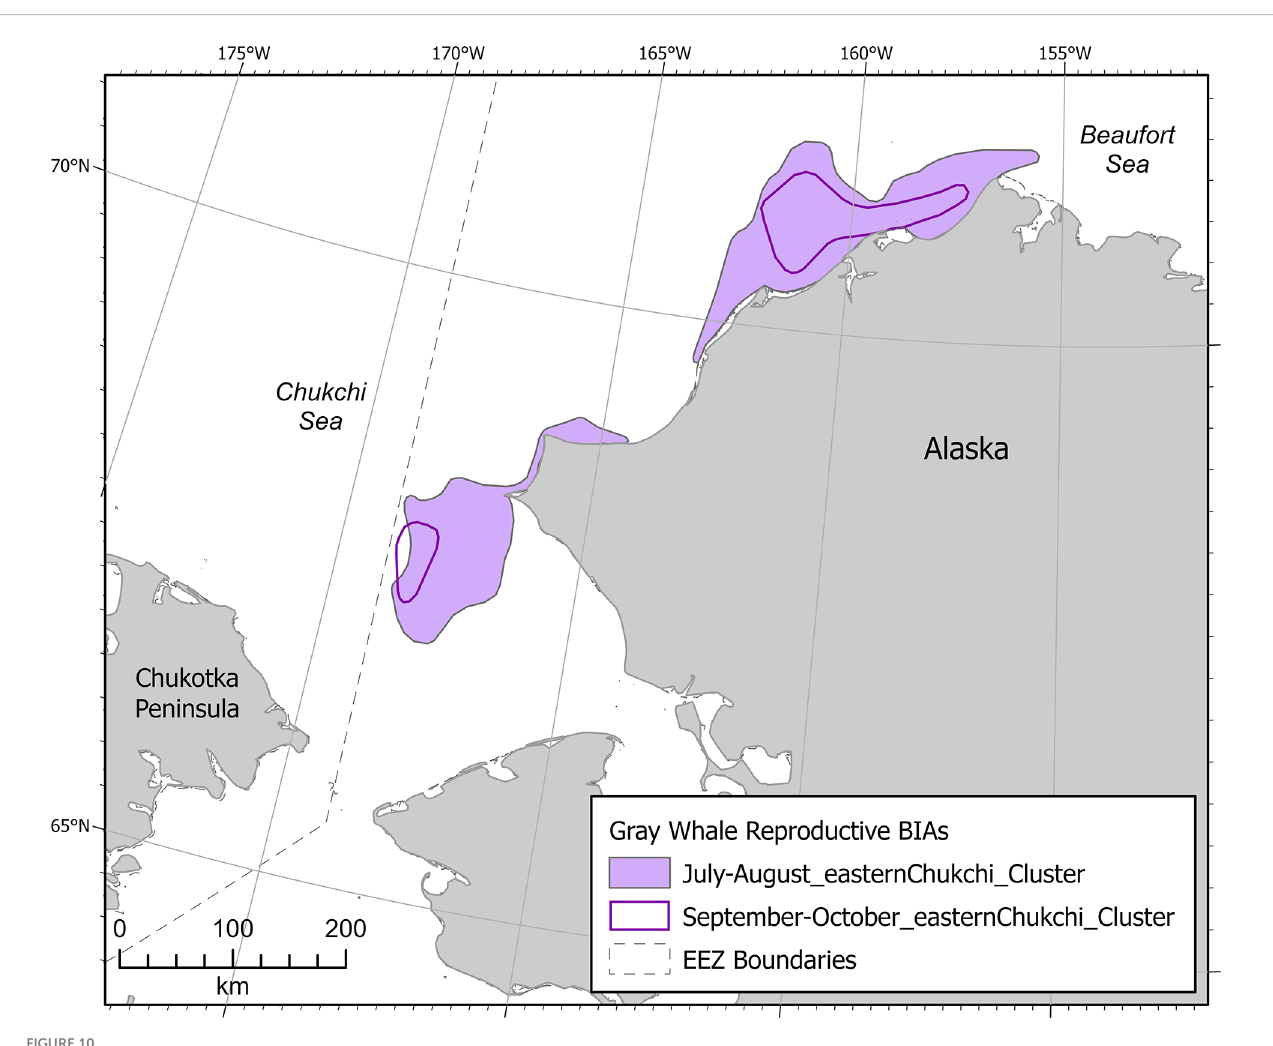
FIGURE 10 Arctic region gray whale reproductive